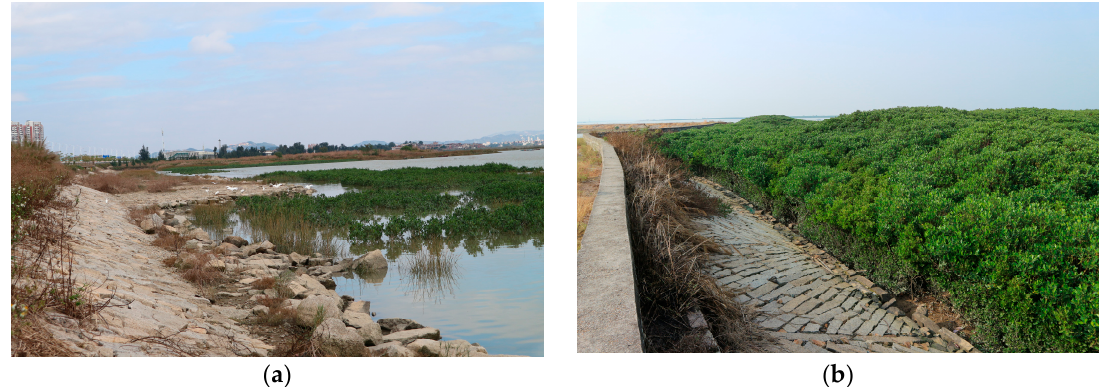
Figure 9. Artificial seawalls with landward mangrove forests. ( a ) Artificial seawall located in the western boundary of the study area; ( b ) artificial seawall located in the eastern boundary of the study area.